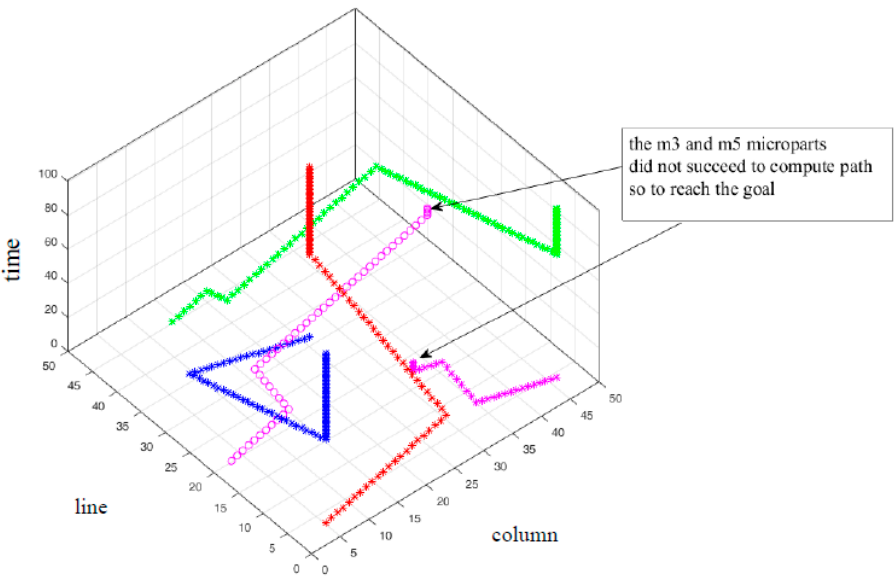
Figure 26. The path of the five microparts in T (time space) with the use of the Equation (13).